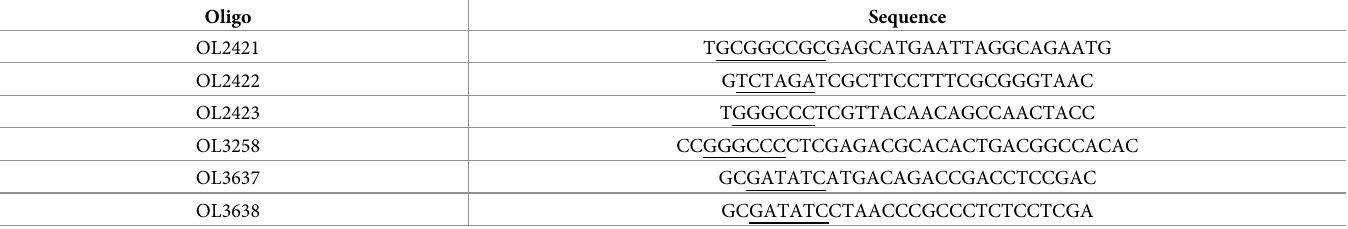
Table 1. Oligonucleotides used to generate constructs.